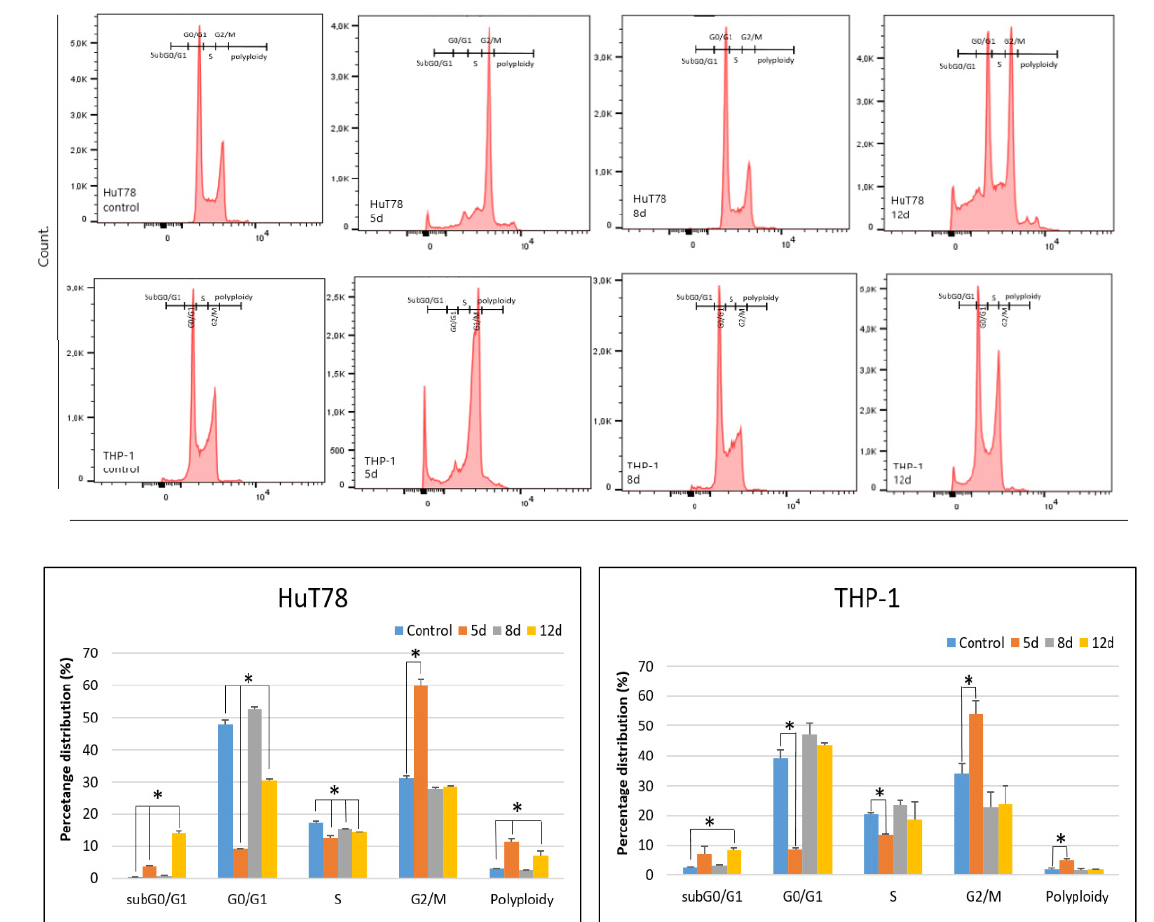
Figure 3. Flow cytometry analysis of the cell cycle distribution of HuT-78 and THP-1 cells exposed to compounds 5d , 8d , and 12d (5 × 10 − 6 M) for 24 h. Data are presented as the mean values ± standard deviations. One-way ANOVA analysis of variance was performed in MedCalc statistical program. p -values less than 0.05 were considered to be statistically significant. An asterisk (*) denotes values statistically significantly different when compared to the control ( p <